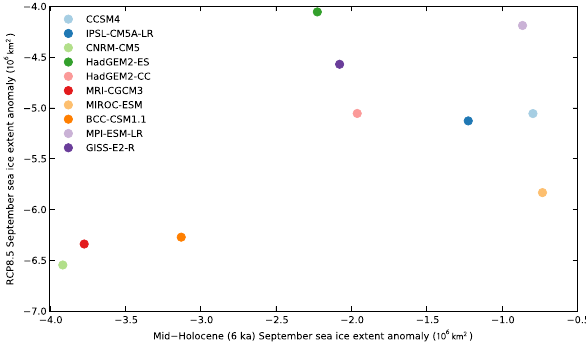
Fig.9. RelationshipbetweentheSeptemberMHanomalyandtheSeptemberRCP8.5anomaly Fig. 8. Relationship between the September RCP 8.8 anomaly (de- across the CMIP5 models. rived from Fig. 7b) and the September MH anomaly (from Fig. 7c) across the CMIP5